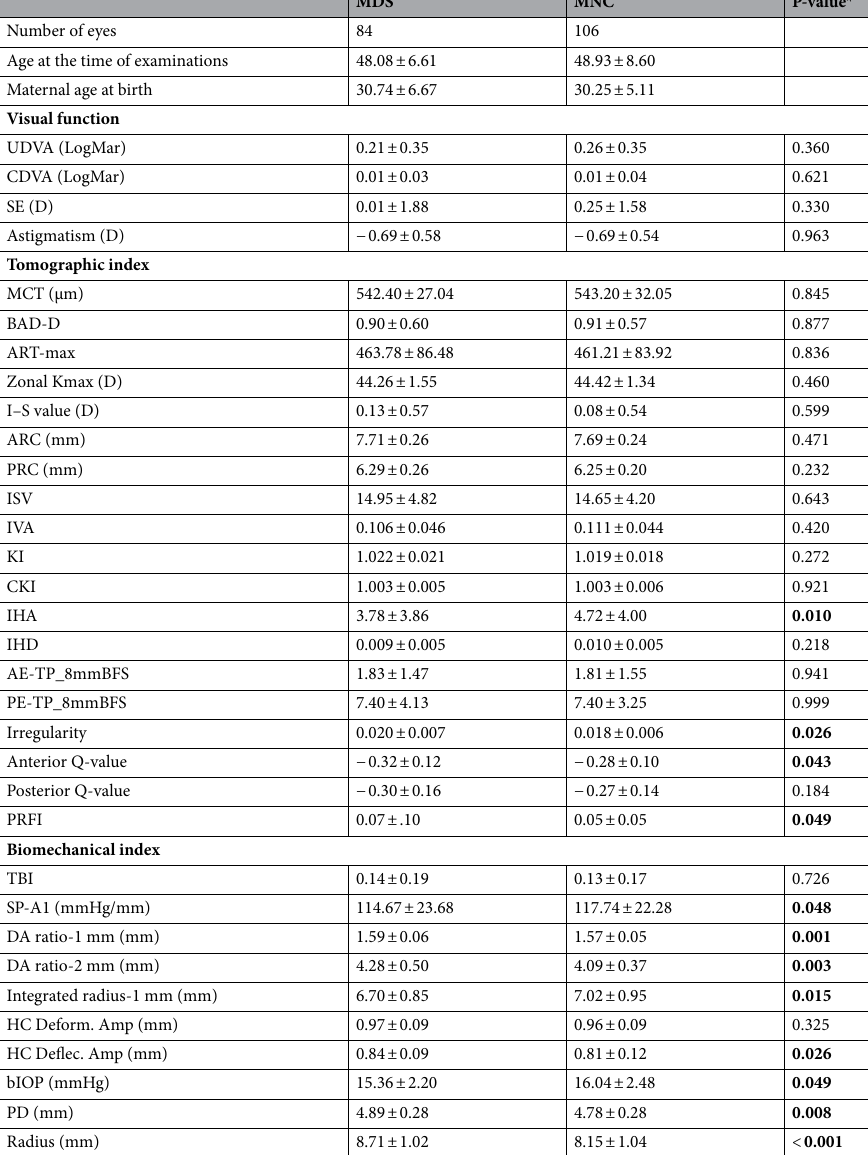
Table 1. Mean ± standard deviation of vision, refraction, tomographic and biomechanical indices in mothers with Down syndrome children (MDS) with normal cornea and mothers with normal children (MNC) with normal cornea. Significant values are in bold. MCT minimum corneal thickness, BAD-D Belin Ambrósio display-total deviation, ART-max maximum Ambrósio’s relational thickness, K keratometry, I–S inferior– superior asymmetry, ARC anterior radius of curvature, PRC posterior radius of curvature, ISV index of surface variance, IVA index of vertical asymmetry, KI keratoconus index, CKI central KI, IHA index of height asymmetry, IHD index of height decentration, AE-TP_8mmBFS anterior elevation at the thinnest point considering 8 mm best-fit-sphere, PE-TP_8mmBFS posterior elevation at the thinnest point considering